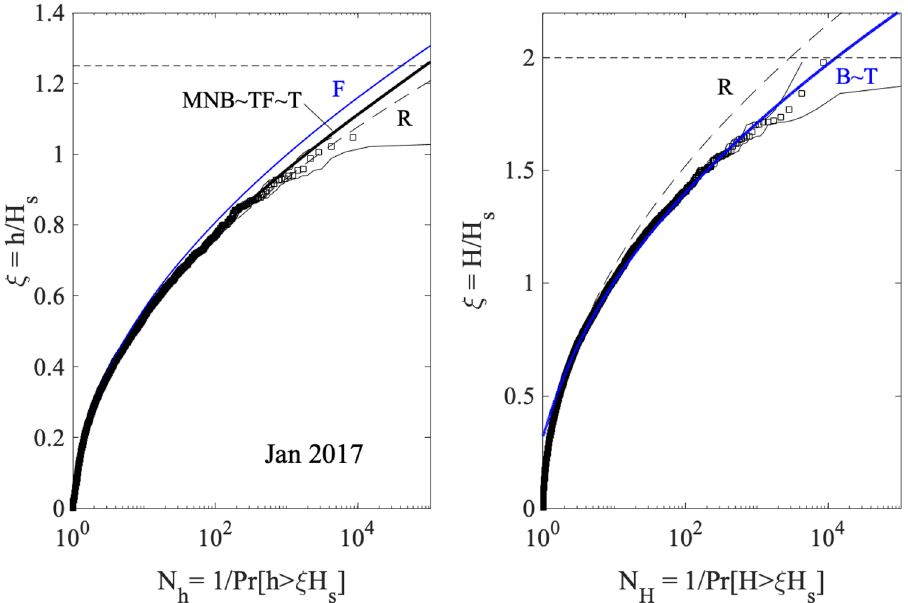
Figure 6. Wave statistics for storm Jan 2017: (left) crest heights h / H s and (right) crest-to-trough wave heights H / H s versus number of waves N h (ξ) . The empirical distribution (squares) from the observed wave ensemble is compared against with theoretical models: T = Tayfun 23, 25 , TF = Tayfun-Fedele 24 , MNB = modified narrow- band 41 , B = generalized Boccotti 42 , F = Forristall 43 and R = Rayleigh distributions. Confidence bands are also shown (light dashes). N h (ξ) is the inverse of the exceedance probability Pr crest-to-trough heights. Horizontal lines denote the rogue threshold 1.25 H s and 2 H s for crest and wave heights 2